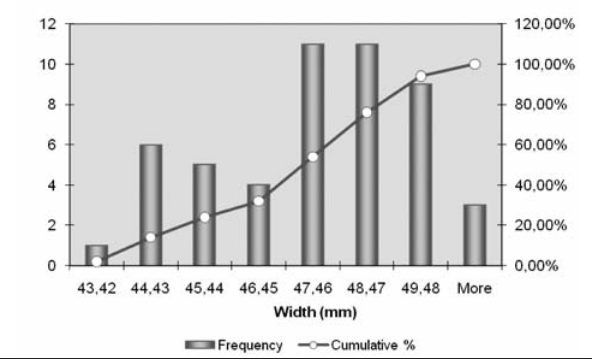
Fig. 15: Distribution of the width values of category A of Hungarian apricot